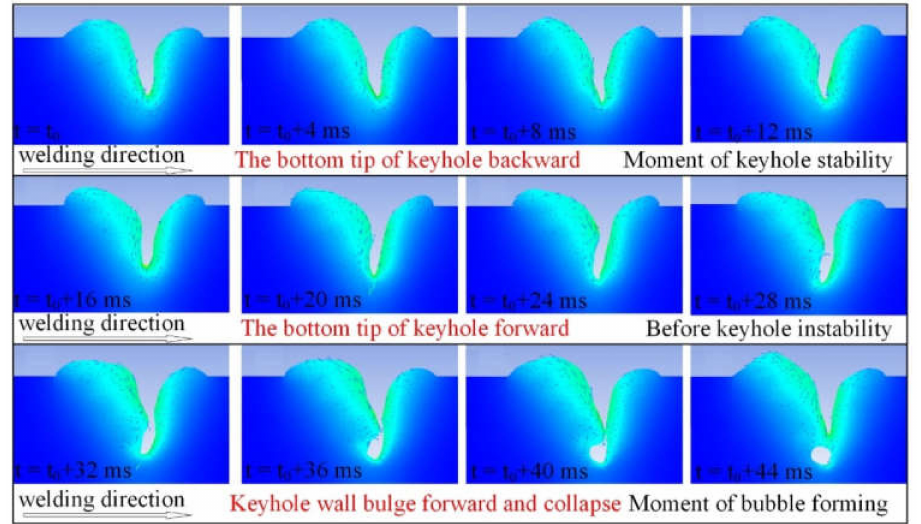
Figure 14. Bubble formation process caused by bulge and collapse of keyhole back